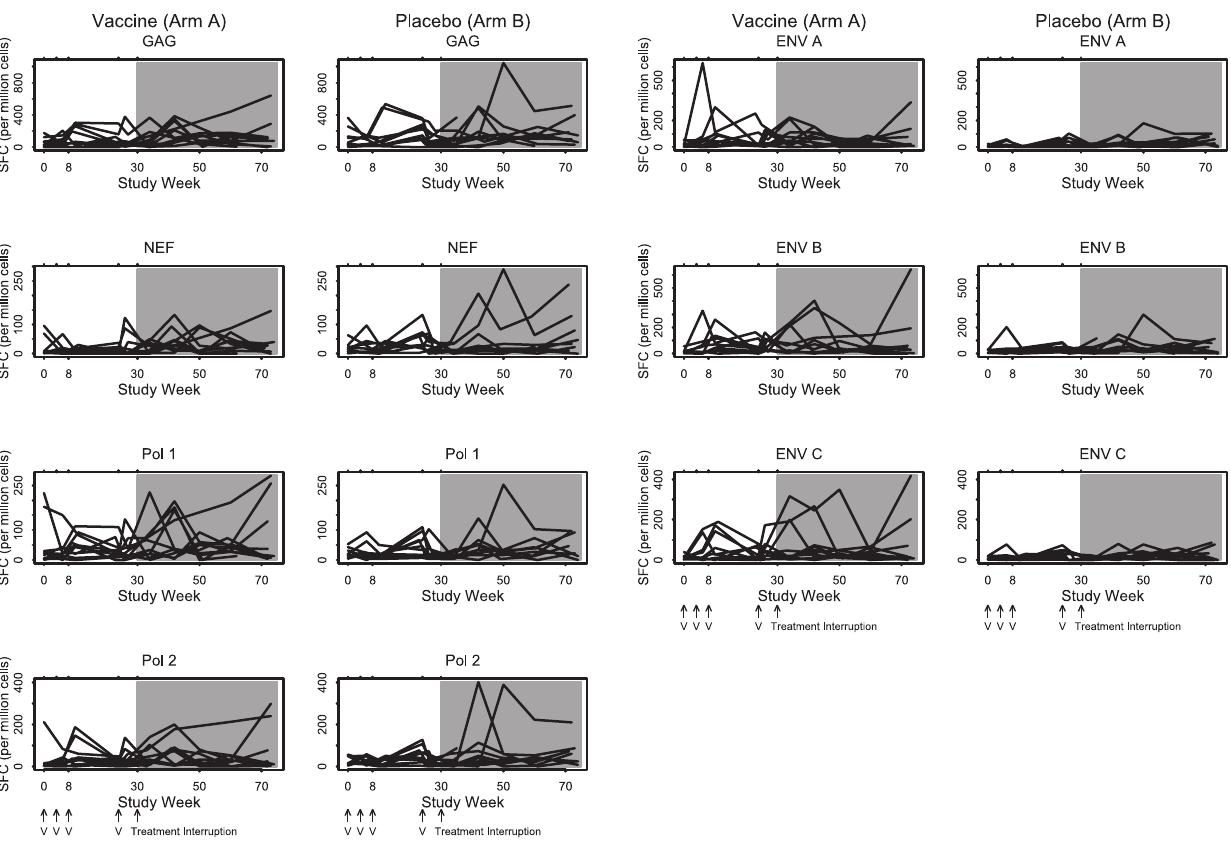
Figure 3. CD4 IFN-- c ELISPOT profile by antigen and treatment arm. Antiretroviral therapy was discontinued at study week 30. Positive responses were defined as a 2-fold increase from baseline that were also $ 100 spot forming cells (SFC) per million PBMC. The symbol V indicates when vaccine or placebo was administered. The shaded area indicates the time period when subjects were off antiretroviral therapy.